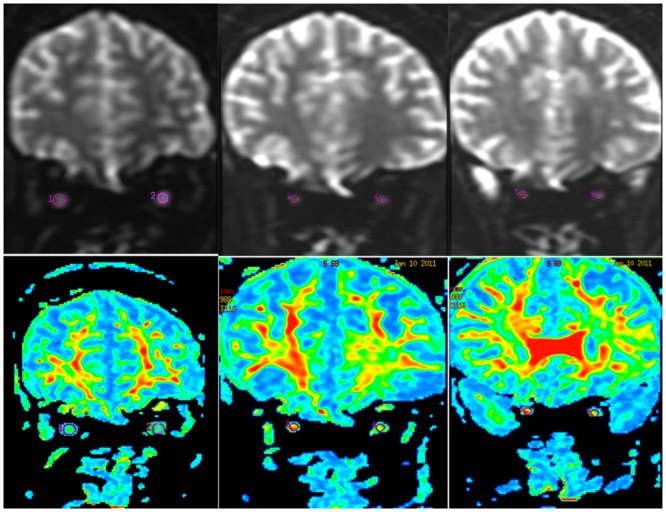
ROIs were placed on B0 images (top line) and FA maps (bottom line) at the anterior (ROI 1 and 2), middle (ROI 3 and 4) and posterior (ROI 5 and 6) segment of optic nerves (green fibers on color-coded structure images) (from left to right).